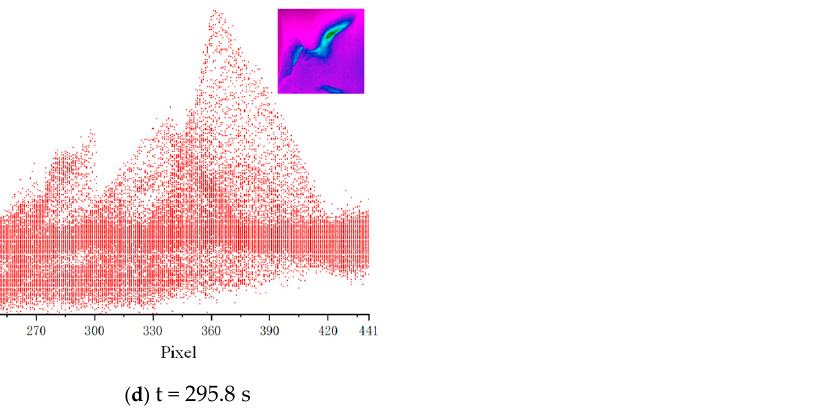
Figure 10. The oscillogram of the temperature in the observation area at the critical moment of the DL5-3 sample destruction.